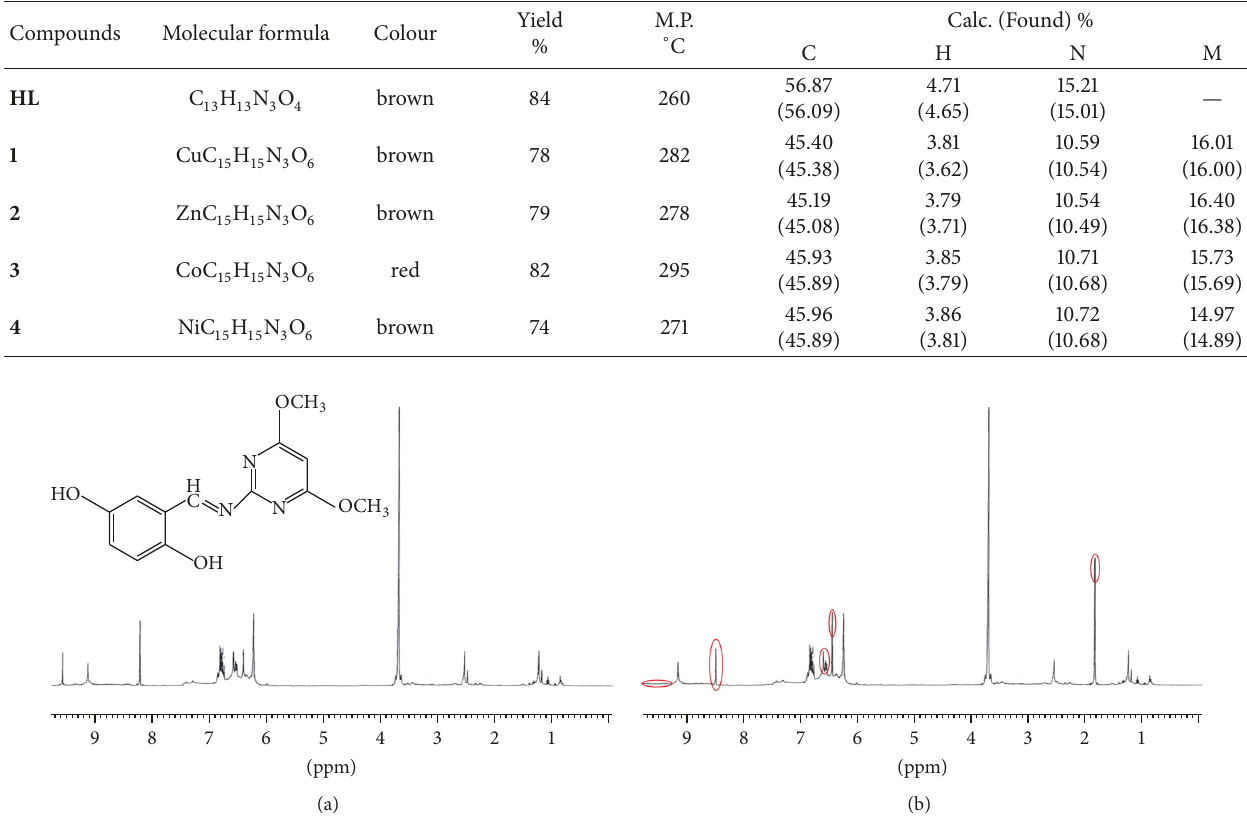
Table 1: Analytical and physical data of the ligand HL and complexes 1 – 4 .